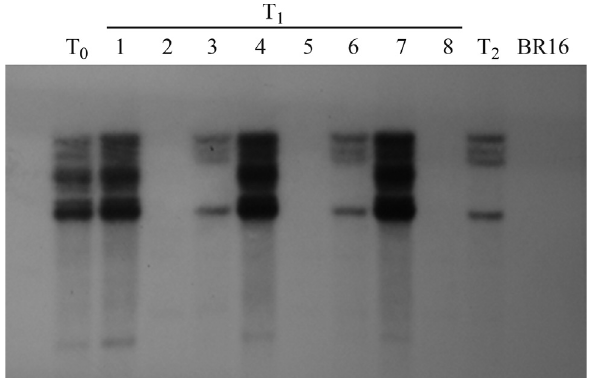
Figure 4 - Southern blot for generations T 0 , T 1 and T 2 of genetically modi- fied P2193 containing the transcription factor At DREB2A. Lanes 1-8 rep- resent T 1 generation plants. BR16 - control (normal) soybean